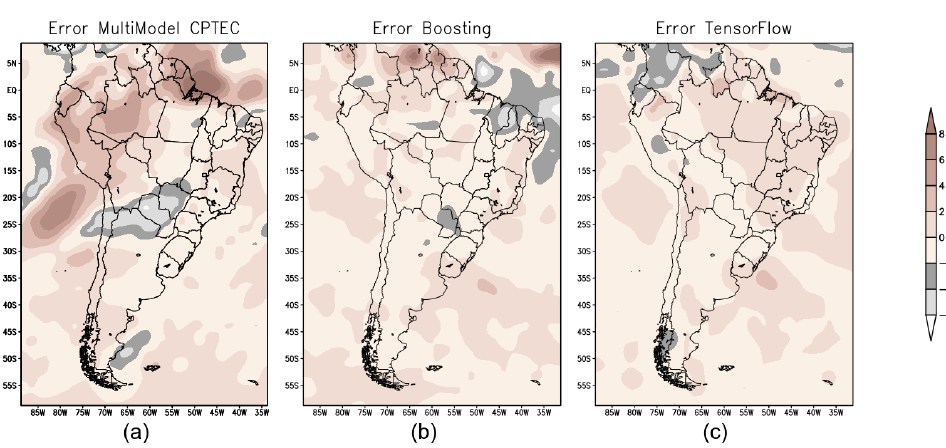
Figure 10. Error map for winter in South America to evaluate the performance of the forecast models: ( a ) BAM; ( b ) XGB; and ( c )